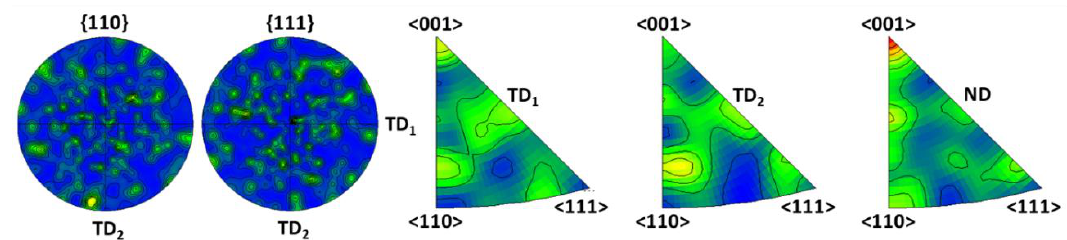
Figure 6. Pole figures (PFs) and inverse pole figures (IPFs) for the FeAl as-cast alloy: TD 1 , TD 2 —orthogonal transverse directions; ND—normal direction.